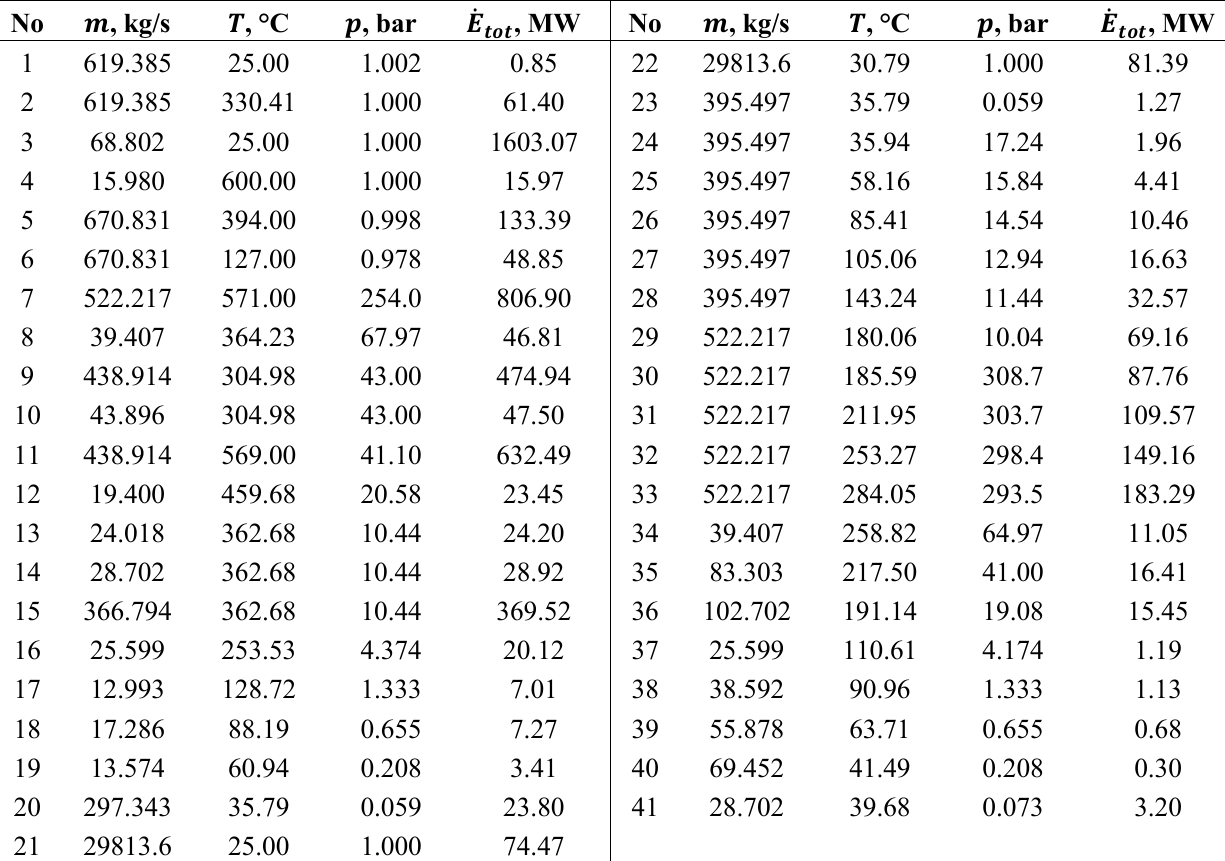
Table 2. Thermodynamic properties of all material